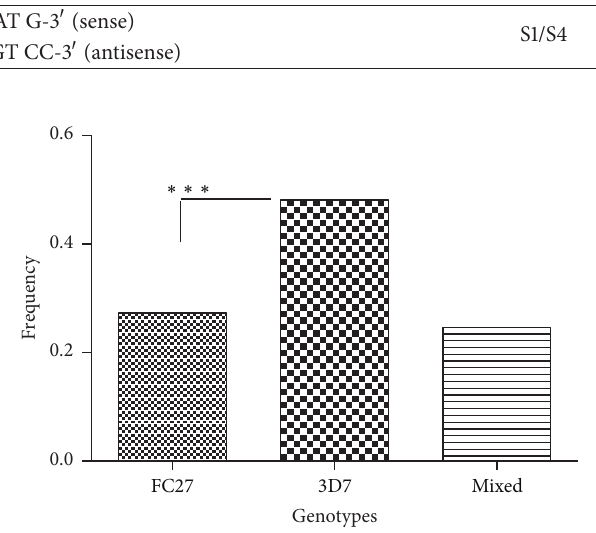
Figure 2: Frequency of occurrence of msp2 genotypes among children under five years at Kibaha ( 𝑁 = 83 ) ( ∗∗∗ significant differ- ence, 𝑝 < 0.05 , 𝑍 -score